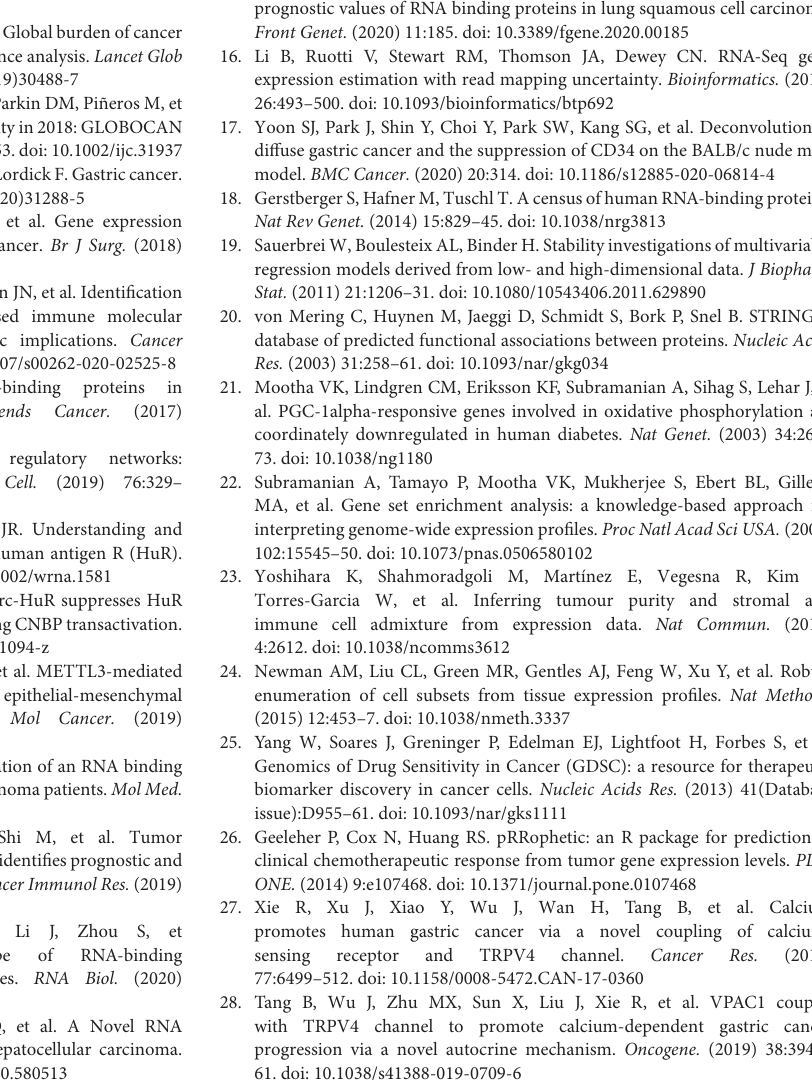
Supplementary Table 1 | Clinical information of gastric cancer patients from TCGA database. Supplementary Table 2 | The clinical information of gastric cancer patients in the GSE84437 dataset. Supplementary Table 3 | A list of 1542